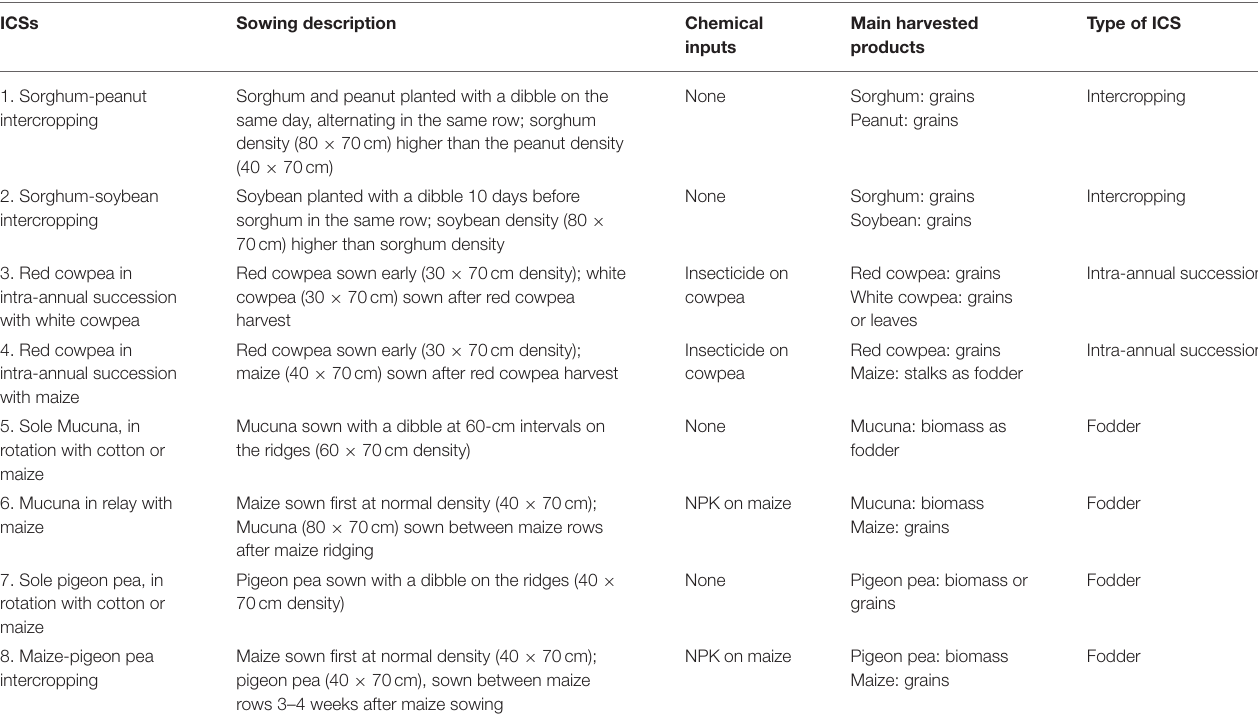
TABLE 1 | Description of the 8 ICSs proposed to farmers as implemented in the PPT after soil preparation by animal traction (ridges spaced 70cm apart) and application of glyphosate to the whole plot.